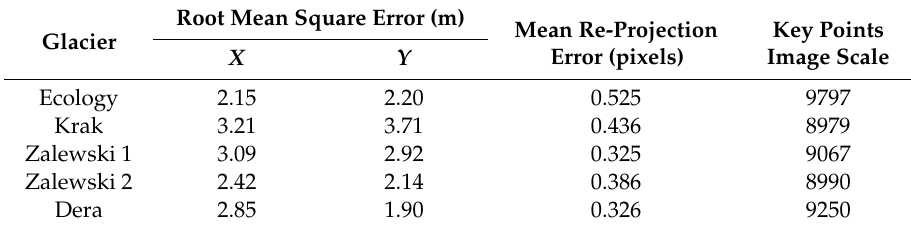
Table 3. Quality report of the completed